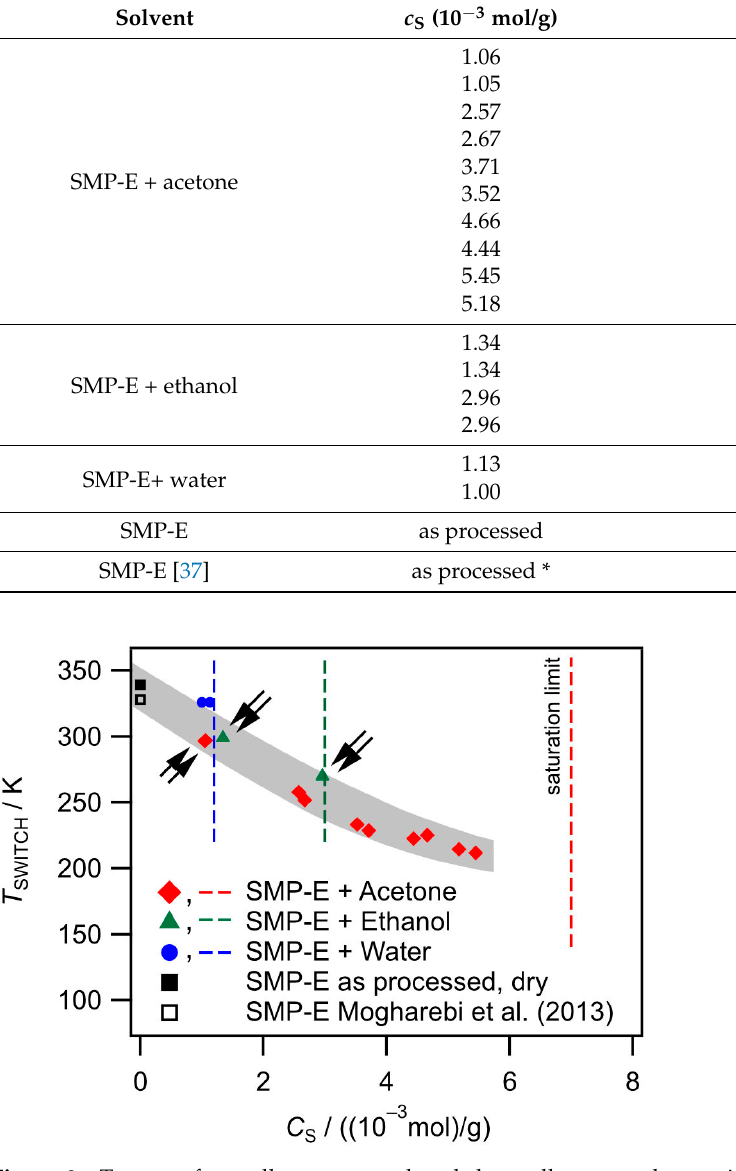
Figure 9. T SWITCH from all as-processed and thermally exposed material states studied in the present